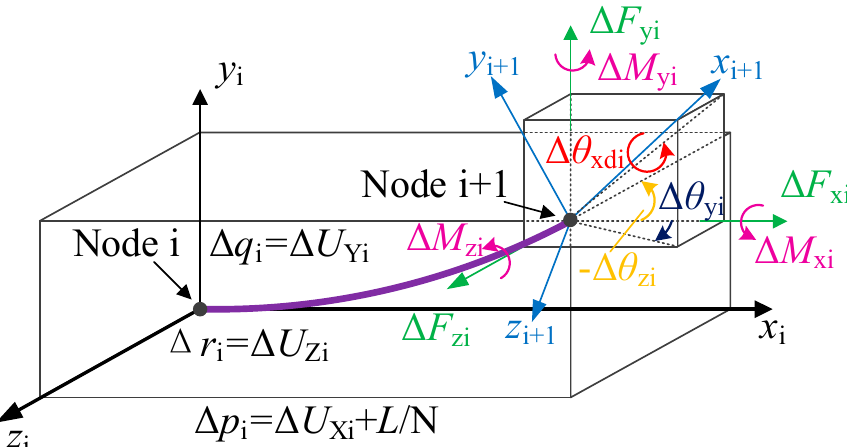
which can be defined as Equation (29):